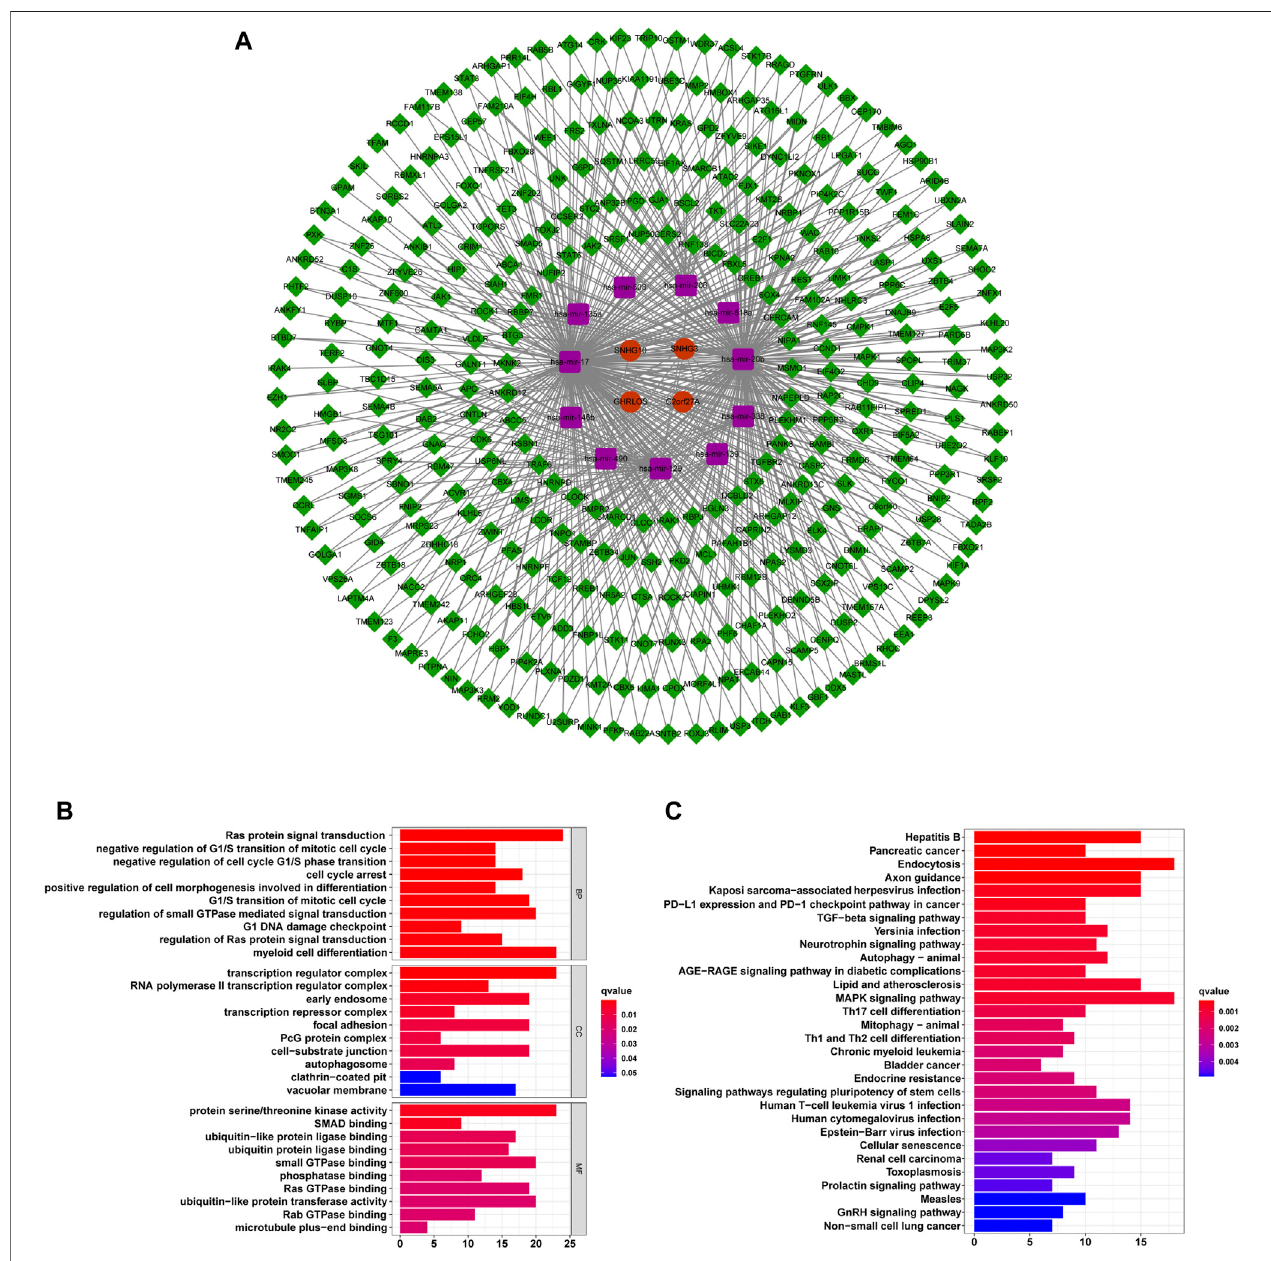
FIGURE 9 | The ceRNA network containing m6ARlncs and their target miRNAs and mRNAs. (A) A ceRNA network containing four m6ARlncs (green), 11 miRNAs (purple), and 352 mRNAs (red). Visualization ofthe results of target mRNA functional signal enrichment, the top fi ve terms of GO (B) and the top 30 pathways ofKEGG (C) .